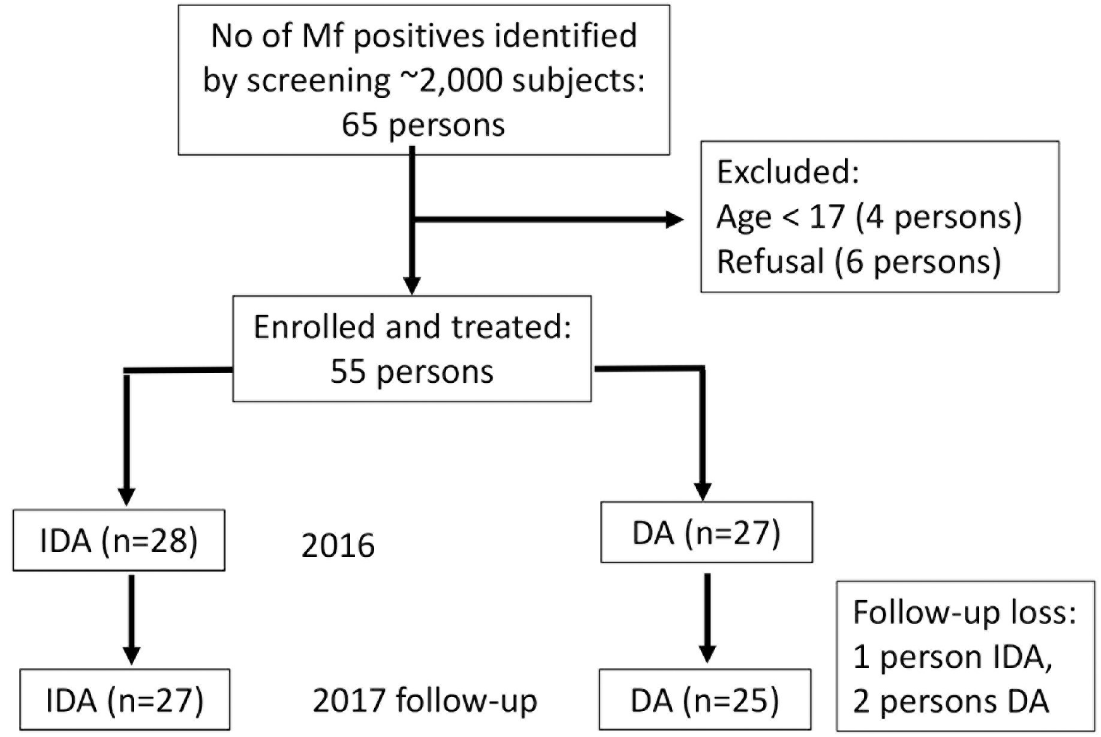
Fig 1. CONSORT diagram showing screening of B . timori microfilaria (Mf) positive subjects, randomization and one year follow-up of the study